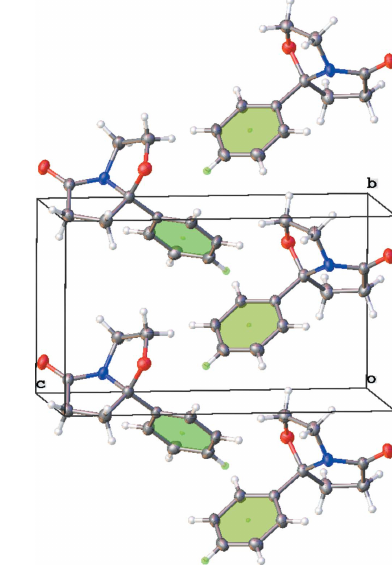
Figure 3 The packing of the title compound showing C—H (cid:3)(cid:3)(cid:3) (cid:2) interactions.